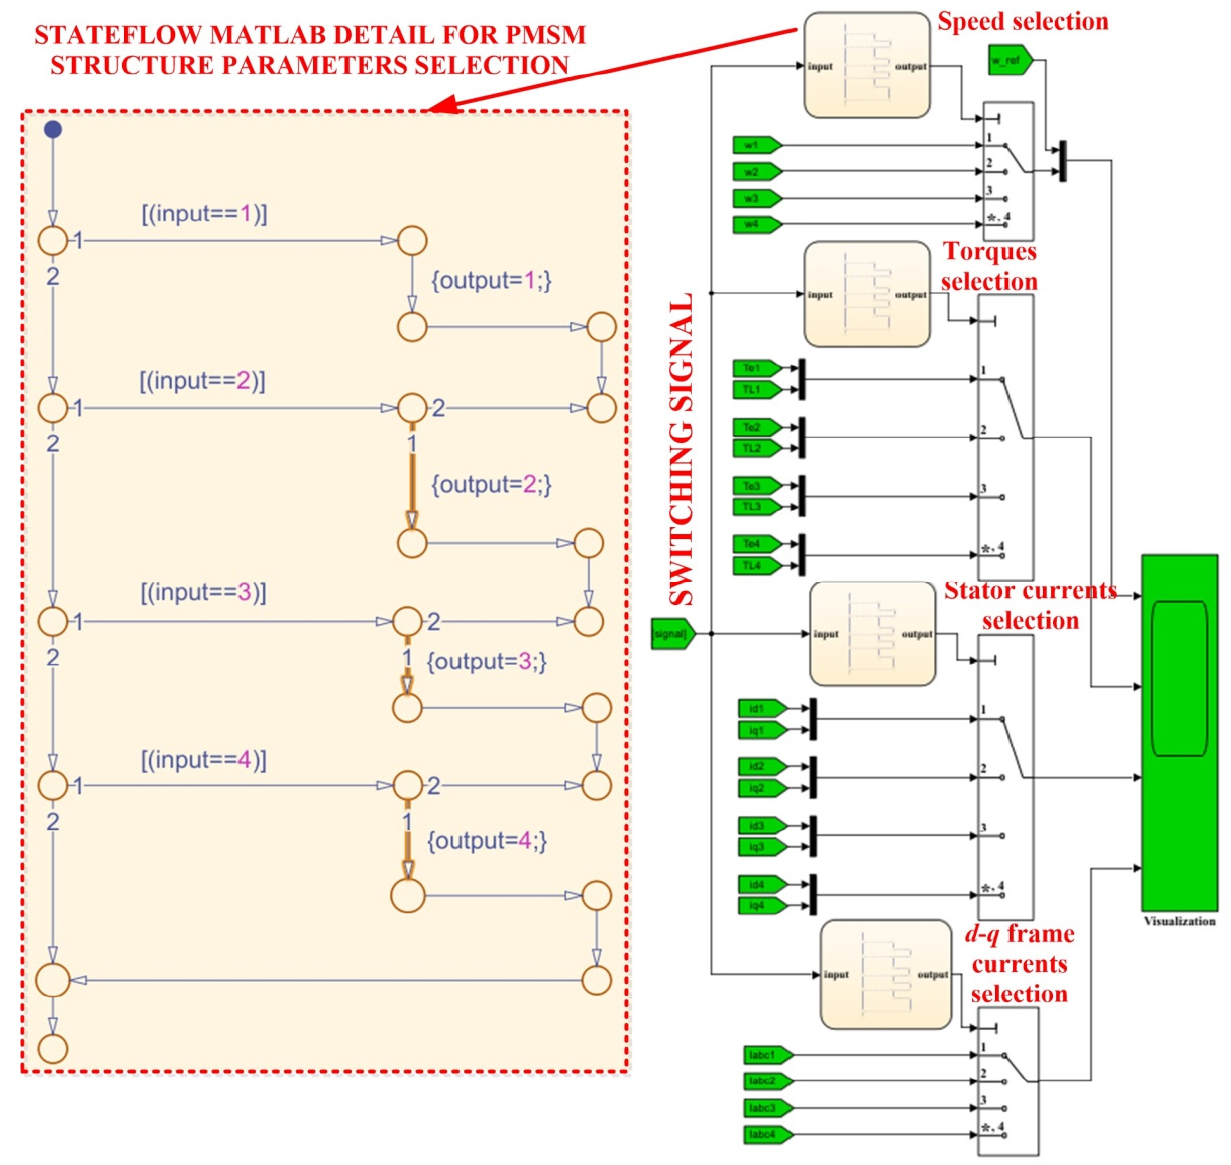
Figure 21. Stateflow Matlab implementation detail for PMSM variable structure used for parame- ters selection from debug, analysis and time evolution subsystem.